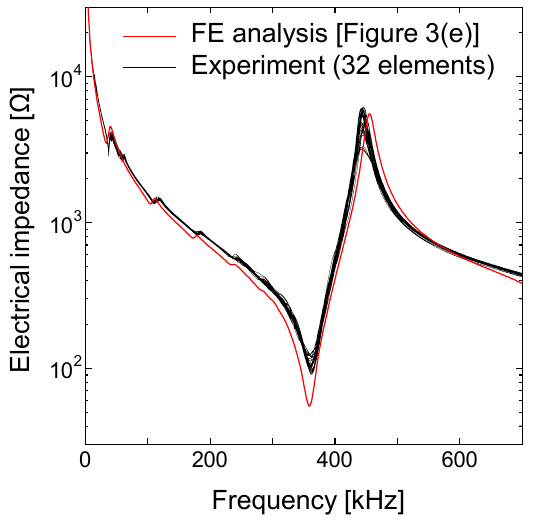
Figure 7. Electrical impedance spectra obtained by experiment and 2D FE simulation. The black curves represent the electrical impedance spectra of all of the fabricated LF array elements. The red curve represents the electrical impedance spectrum (Figure 3e) predicted by 2D FE simulation.